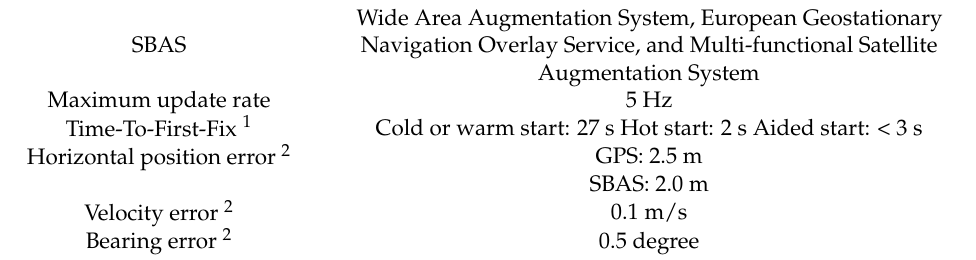
Table 2. U-blox NEO-6M mini GPS module main features [56]. Wide Area Augmentation System, European Geostationary SBAS Navigation Overlay Service, and Multi-functional Satellite Augmentation System Maximum update rate 5 Hz Time-To-First-Fix 1